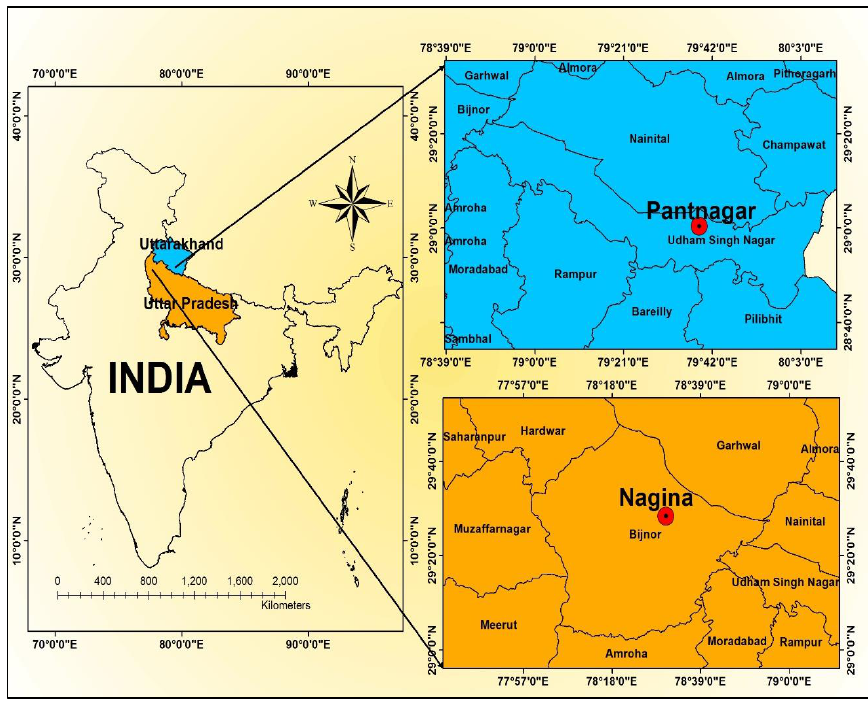
Figure 1. The coordinates of the investigated meteorological stations in Uttarakhand State and Uttar Pradesh State, India.